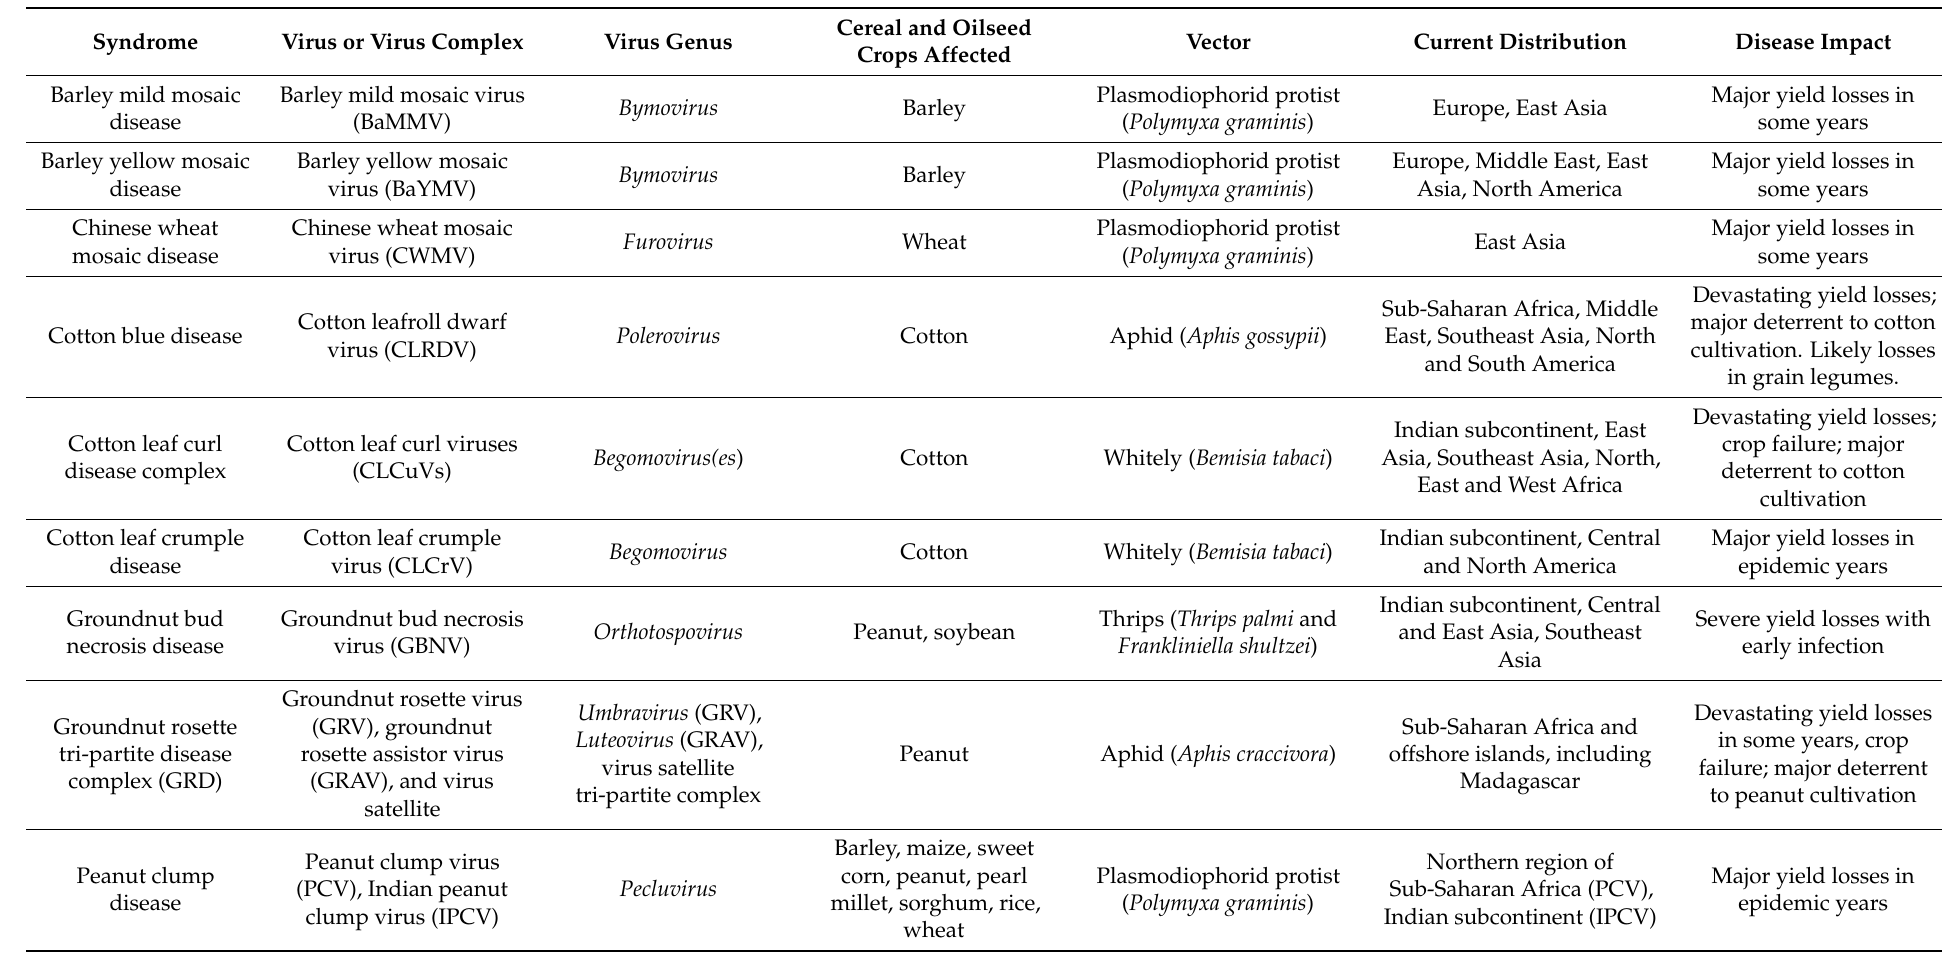
Table 4. Cereal and oilseed virus diseases that pose a biosecurity threat to